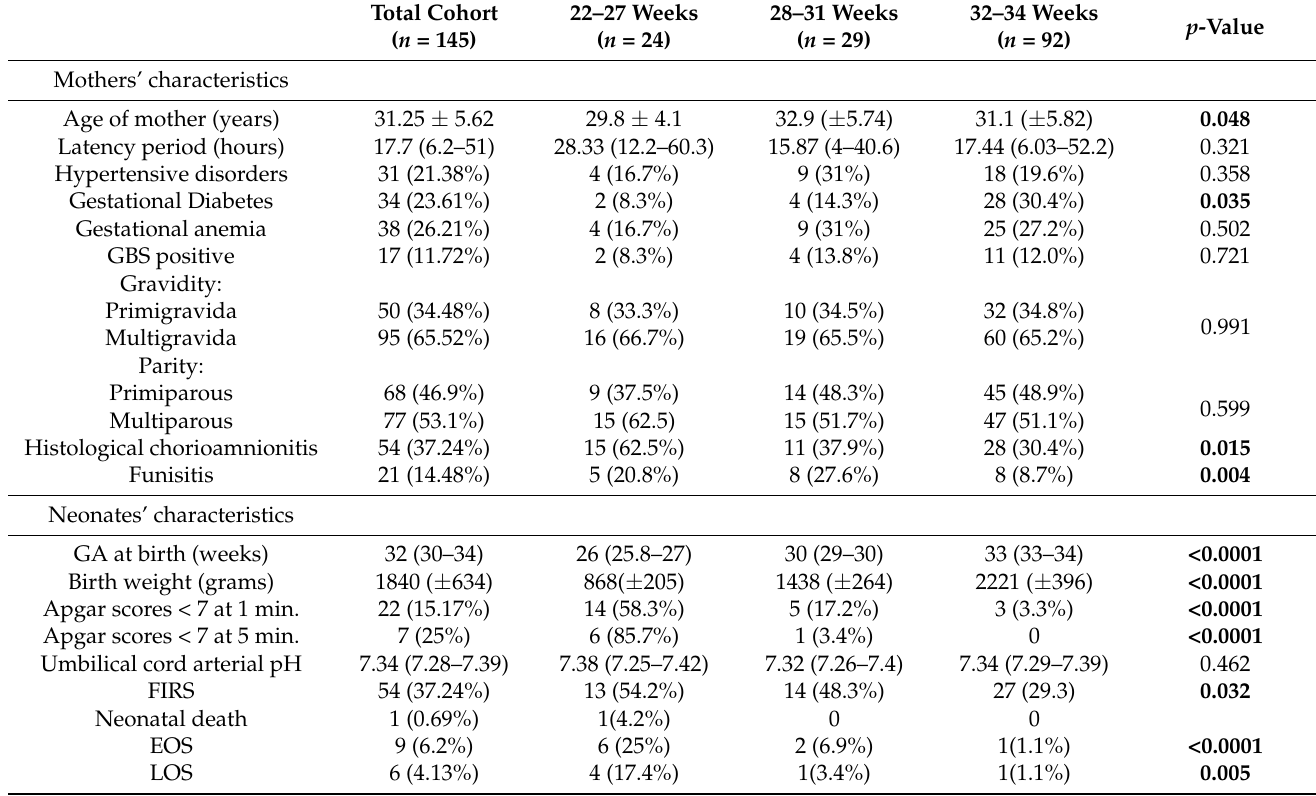
Table 4. Demographic and clinical characteristics of the total study population, and three gestational age groups, separately. The data are presented as median (interquartile range) or mean with standard deviation for continuous variables and as number (percent) for categorical variables. Significant